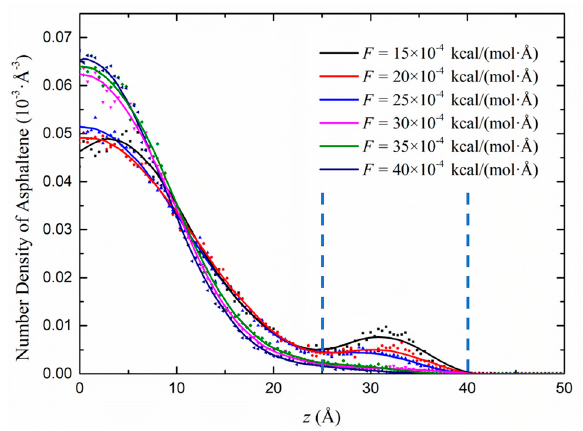
Figure 5. The density profile of the asphaltene at different driving forces. T = 300 K. The dashed blue lines are the borders of the KML, RAL, and FSL.